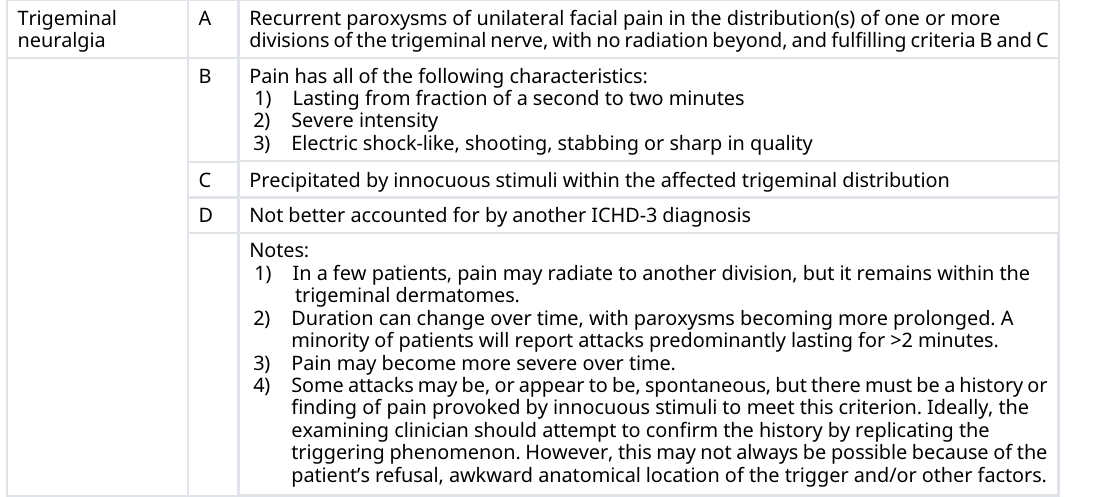
Table 2. Diagnostic criteria for the diagnosis of Trigeminal Neuralgia (ICHD-3 classification 23 ). Trigeminal